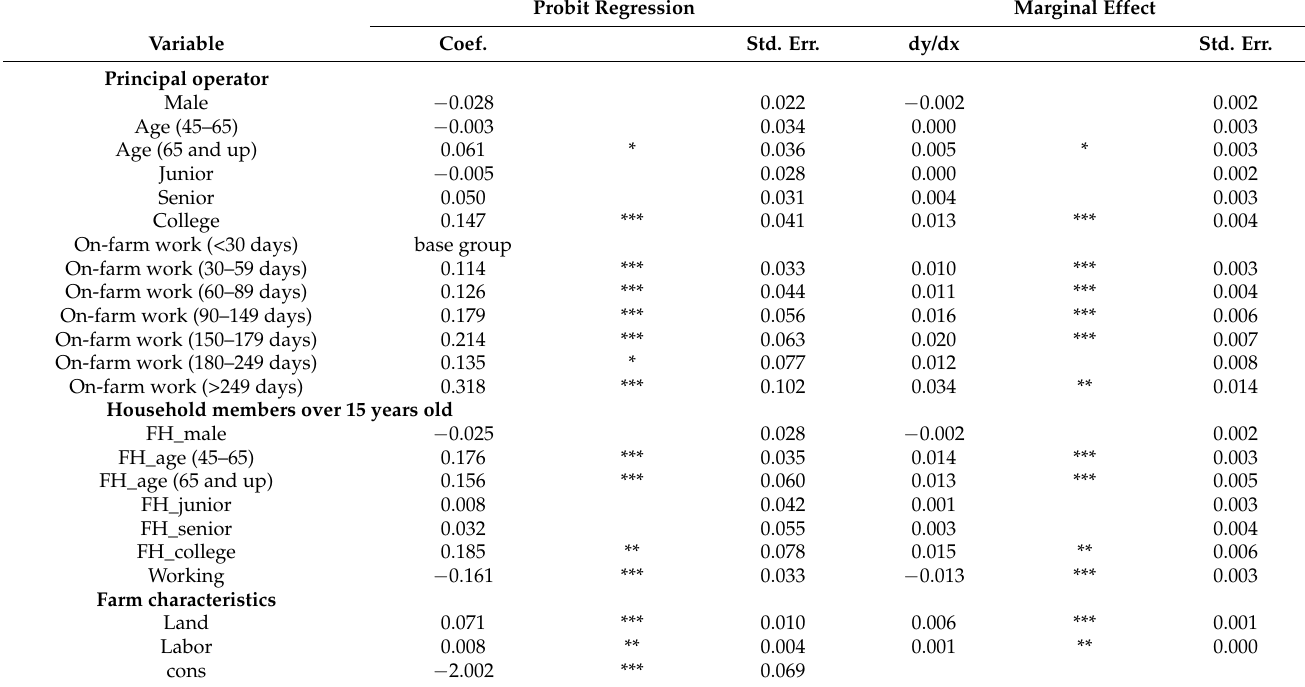
Table 2. Coefficient estimates and marginal effect. Probit Regression